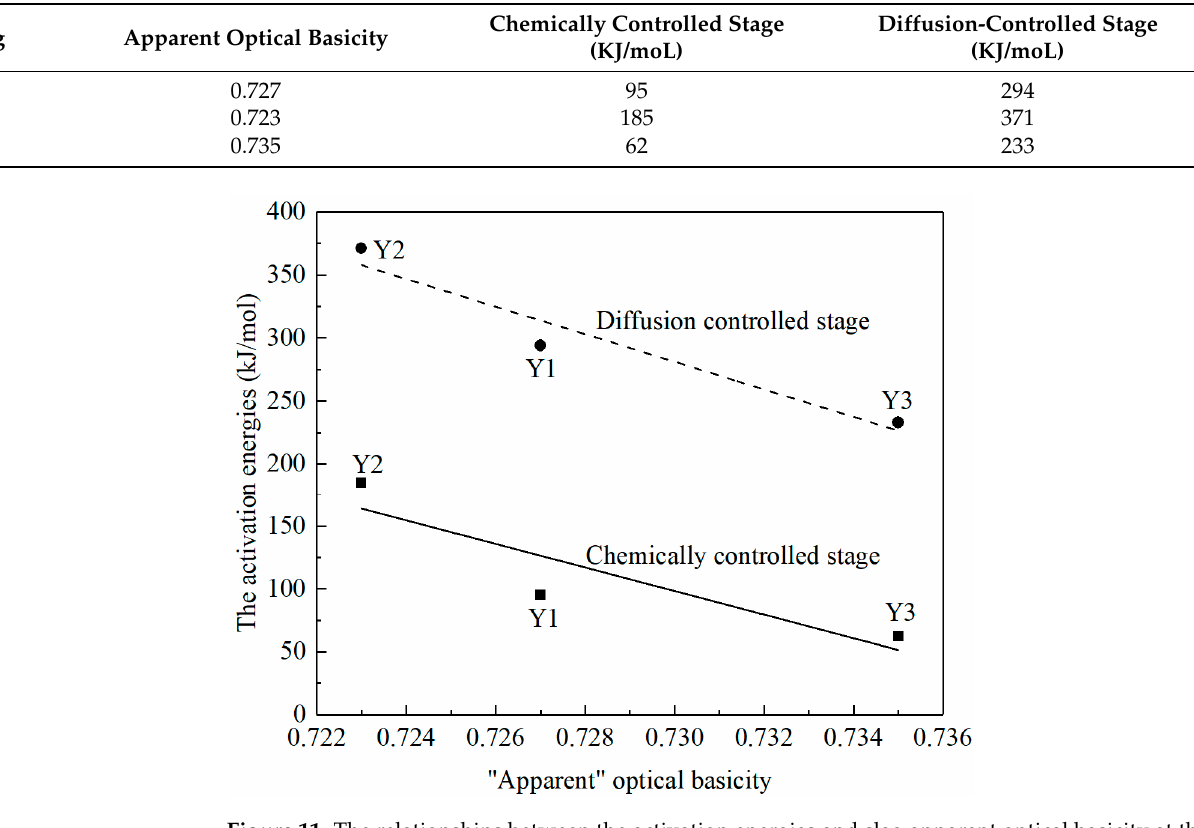
Table 7. The compositions and activities of the liquid slags at 1473 K are calculated by FactSage; the liquid optical basicity is calculated from liquid compositions and the data in Table 1. Slag